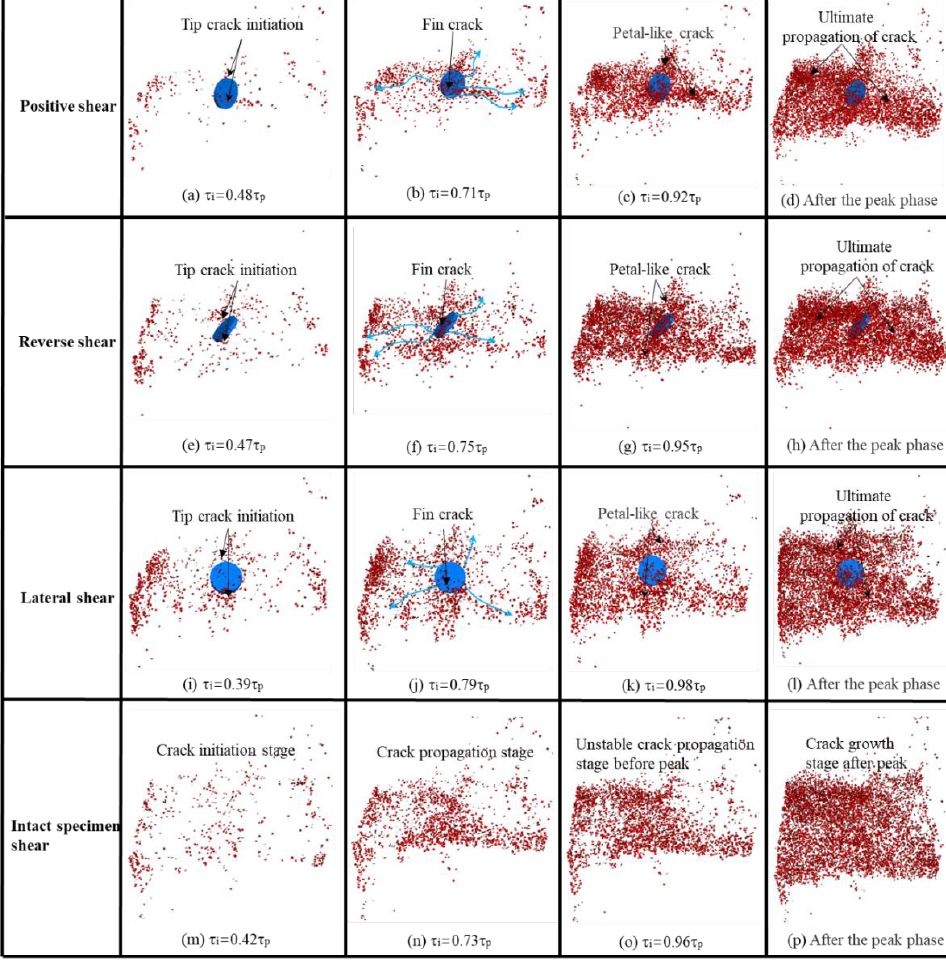
Figure 14. Microcrack propagation of four groups of models in different servo loading stages. loading process of four groups of different models under the conditions of σ n = 2 MPa and α = 45 ◦ . The left longitudinal axis indicates the ratio of τ i to τ p (percentage), the red axis on the right is the number of new breakages added every ten steps, and the blue